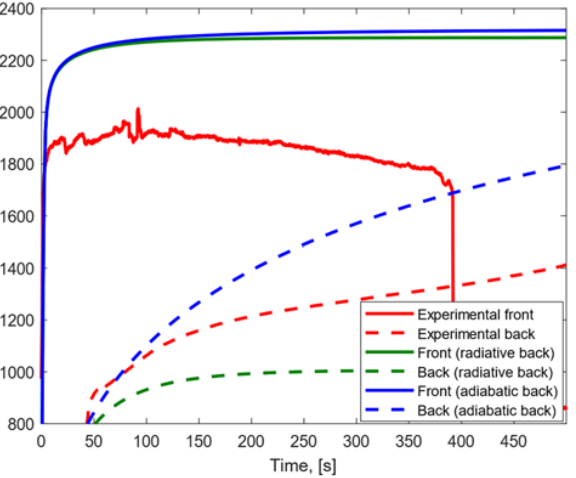
Figure 8. Experimental and modeling temperature profiles for CFRP subjected to high heat flux. Case ‐ study 2: Stainless Steel AISI316L